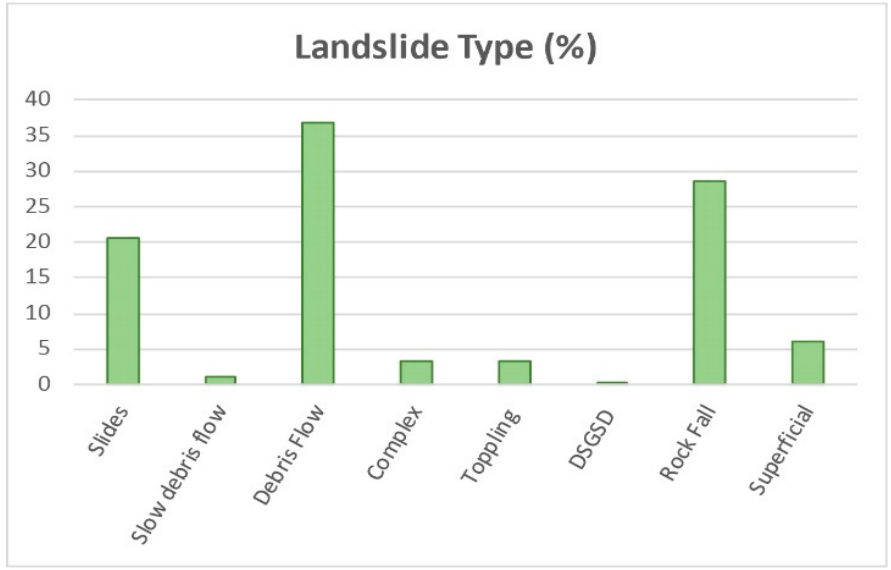
Figure 3. Landslides type in Lombardy Region (Italy). Data from Regione Lombardia, [40] in the framework of IFFI project.